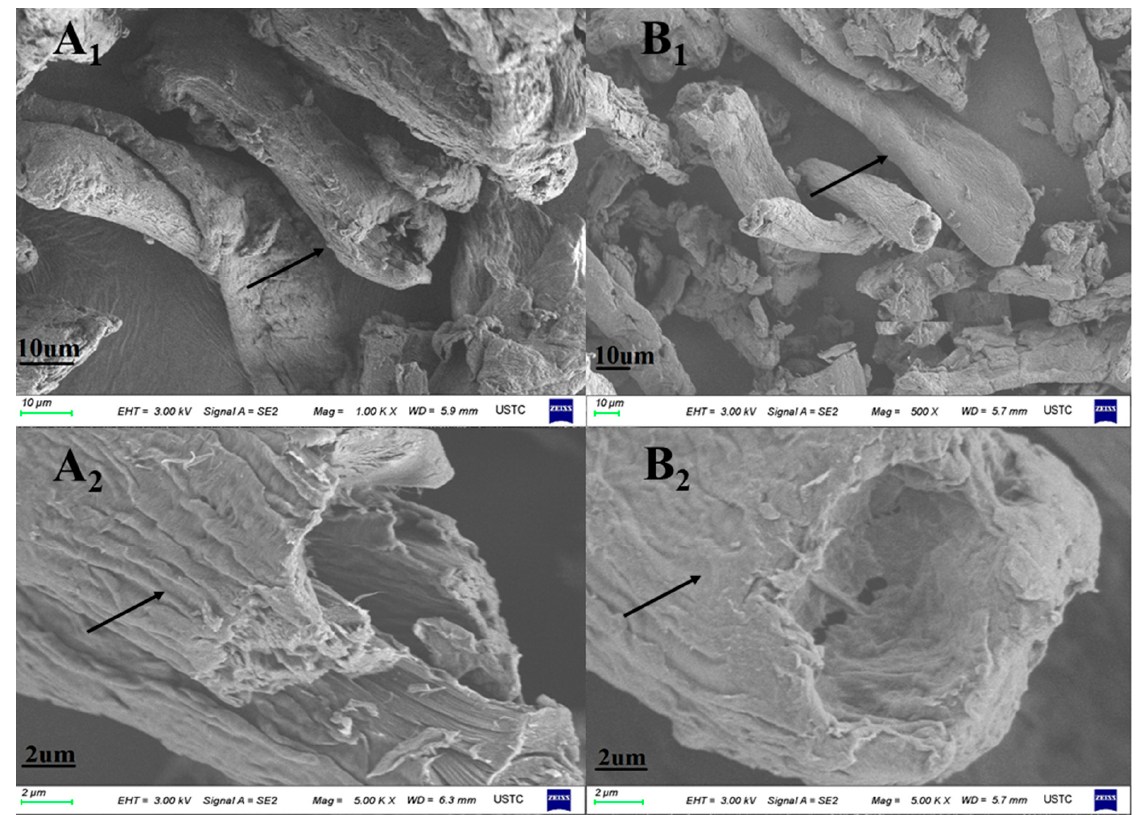
Figure 3. SEM micrographs of ( A 1 , A 2 ) MCC and ( B 1 , B 2 ) MCC-g-LMA. The position indicated by the arrow represents the characterization difference of different flocculants under SEM. Table 2. SEM specific parameters.